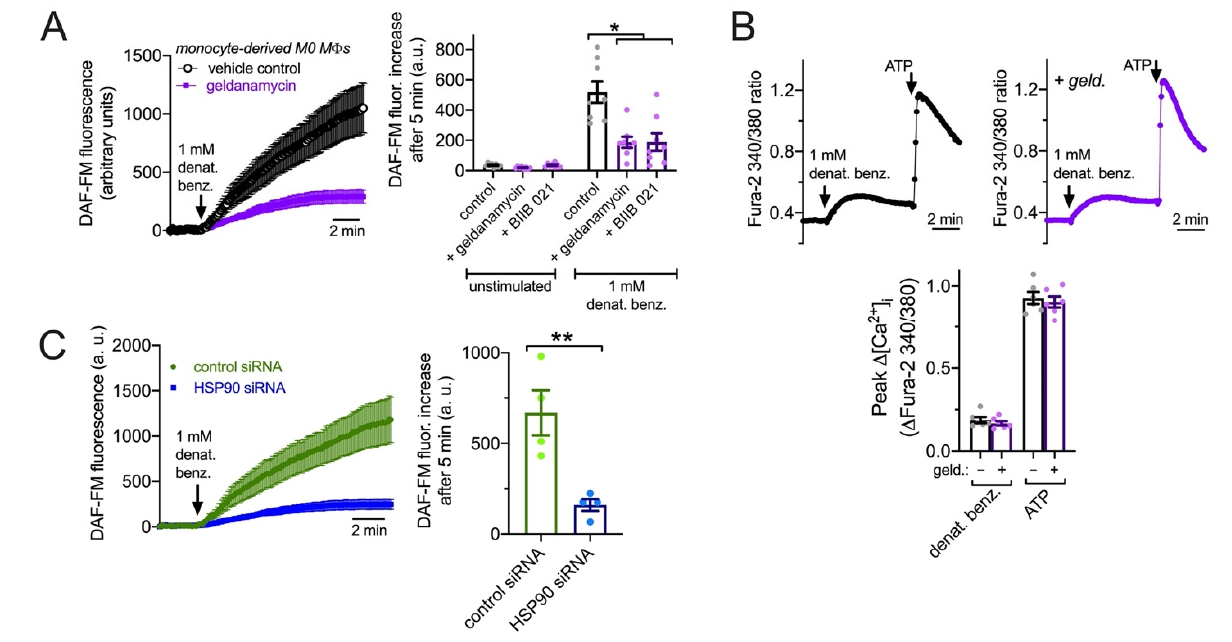
Figure 9. HSP90 inhibition reduces T2R-stimulated NO production in primary human M0 M Φ s. ( A ): DAF-FM-loaded M Φ s exhibited increases in fluorescence in response to 1 mM denatonium benzoate that were strongly inhibited by geldanamycin. Left shows average traces and right shows bar graphs (mean ± SEM) from eight independent experiments using M Φ s from two donors. DAF-FM fluorescence increase was also inhibited by BIIB 021. Control = denatonium benzoate after pretreatment with 0.1% DMSO. Significance by one way ANOVA with Bonferroni posttest; * p < 0.05. ( B ): Low-level Ca 2+ responses to denatonium benzoate were not affected by geldanamycin. Top shows representative traces in the absence or presence of 1 µ M geldanamycin. Bottom shows bar graph of six independent experiments using M Φ s from three different donors. Response to purinergic agonist ATP shown as control. ( C ): NO production in M Φ s treated with HSP90 or control non-targeting siRNAs. Left shows representative traces and right shows bar graph of data from four independent experiments per condition. Significance by Student’s t -test; ** p < 0.01.